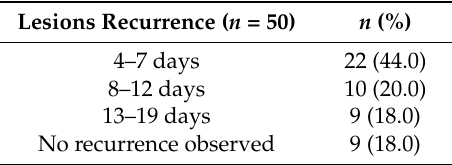
Table 4. Period of oral mucositis